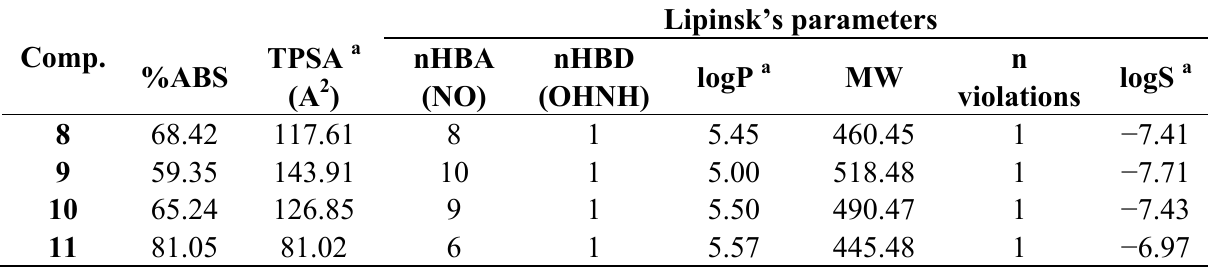
Table 2. Lipinsk’s parameters and % ABS, TPSA, LogS for compounds 8 – 11 .